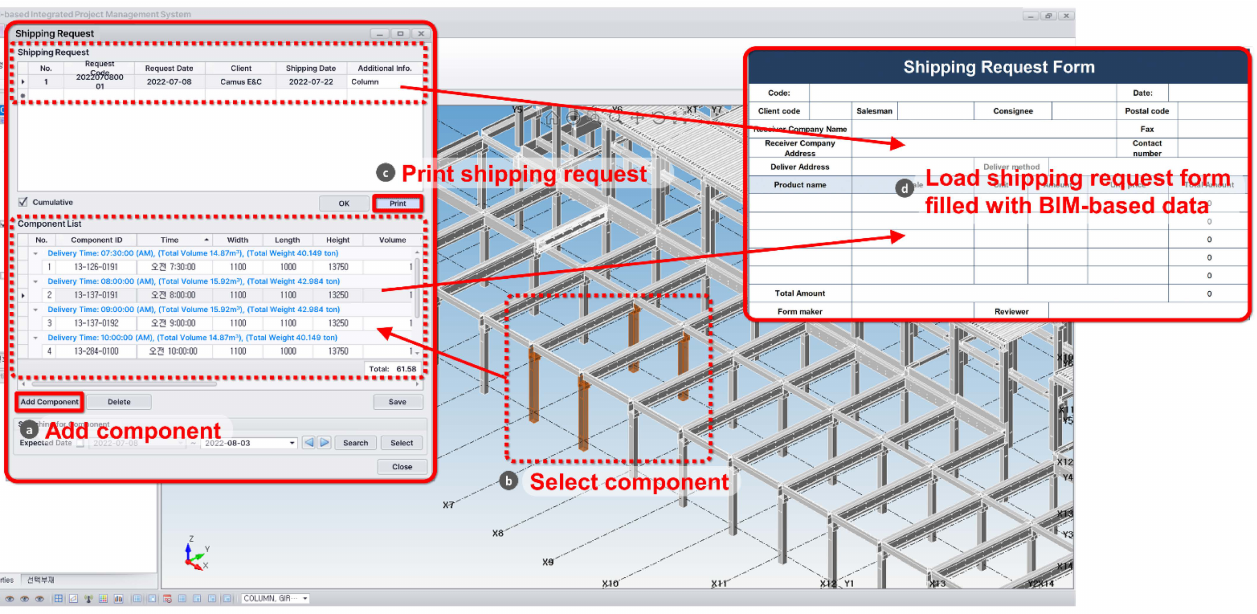
Figure 6. UI for shipping